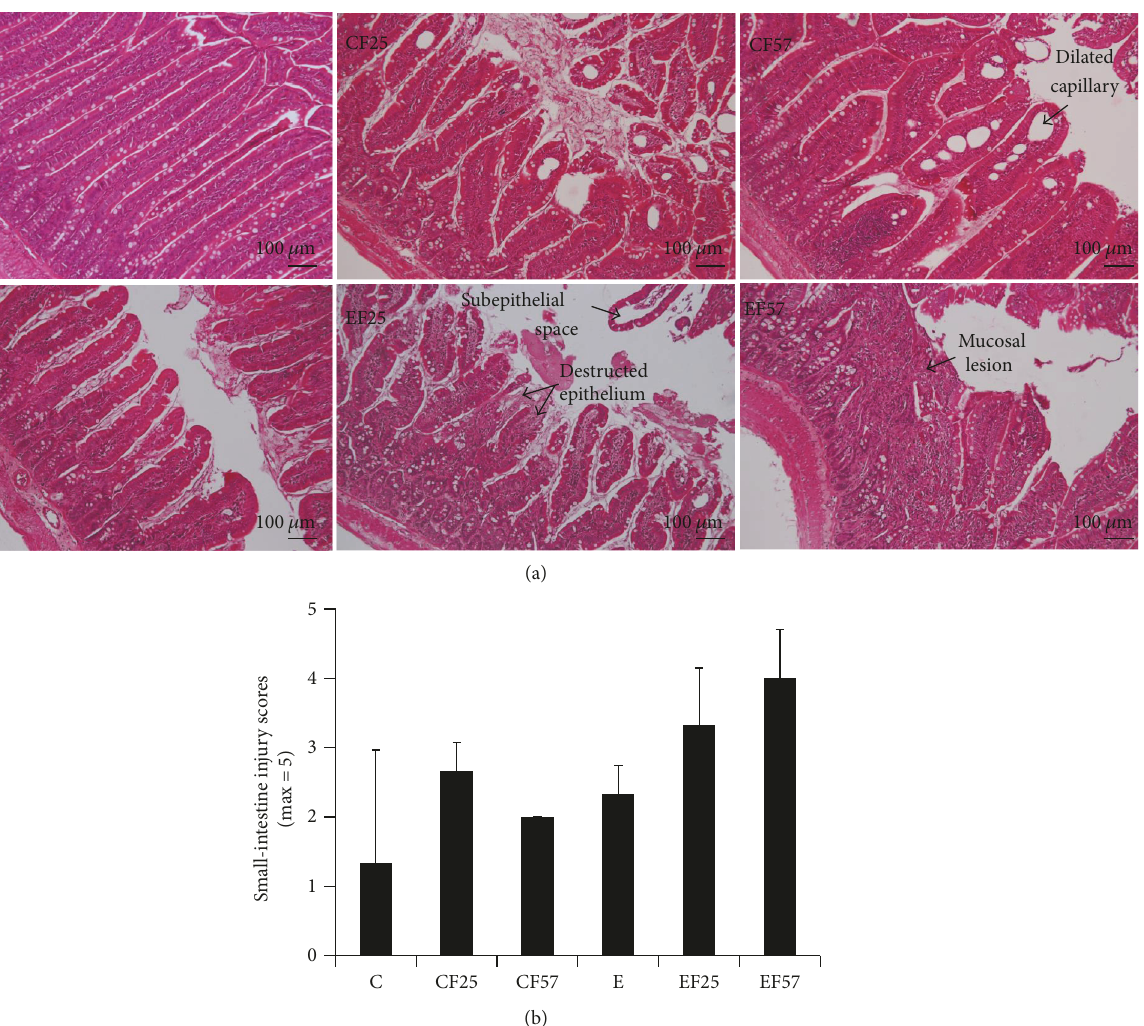
Figure 3: Score of small-intestinal injury in each group. C: control group; CF25: control diet with fi sh oil substituted for 25% of olive oil; CF57: control diet with fi sh oil substituted for 57% of olive oil; E: ethanol group; EF25: alcohol-containing diet with fi sh oil substituted for 25% of olive oil; EF57: alcohol-containing diet with fi sh oil substituted for 57% of olive oil. (a) Representative histological images of rats in all groups at 100x magni fi cation. (b) Quanti fi cation of the small-intestinal injury score among